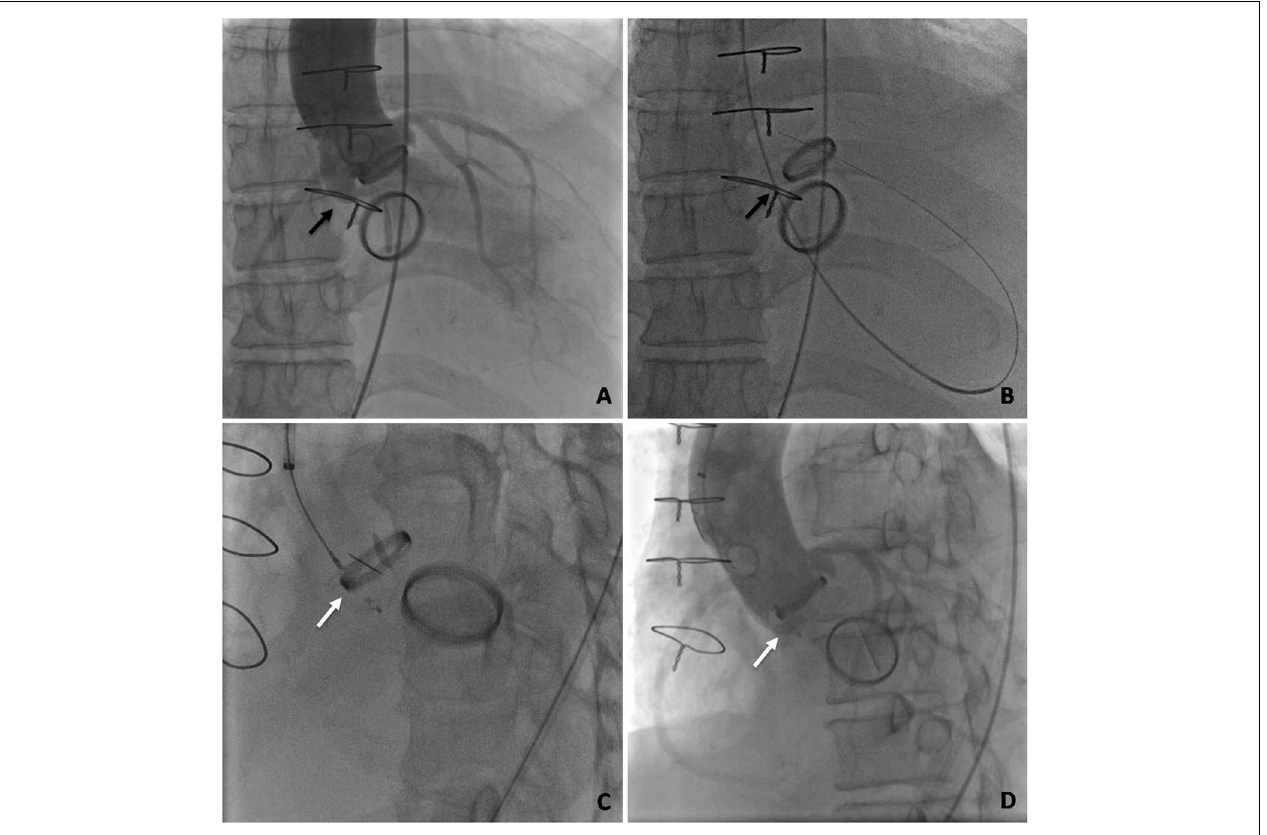
FIGURE 4 | Angiography profiling of the transcatheter closure of an aortic mechanical PVL. (A) Ascending aorta angiogram to profile para-aortic regurgitation. (B) Retrograde crossing of the PVL with a guidewire. (C) An occluder placed at the position of the PVL. (D) Ascending aorta angiogram after deployment. (The black arrow indicates the PVL. The white arrow indicates the